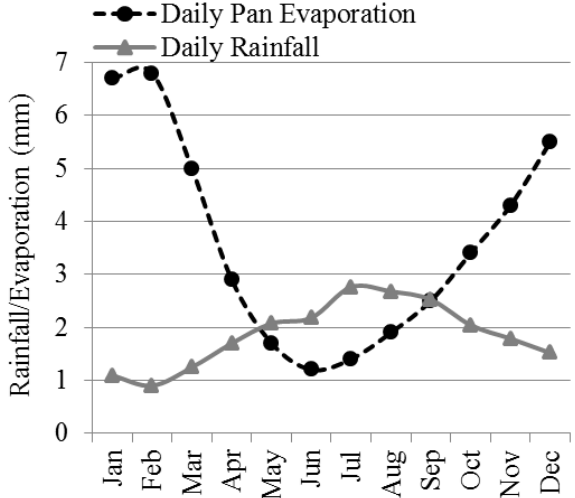
Figure 2. Average daily rainfall and potential evaporation for the study region, based on data from 1965–2000, Hamilton, Victoria, Bureau of Meteorology.